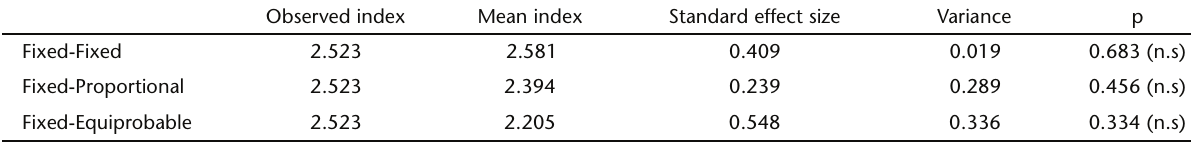
Table II. Results of null model analysis for co-occurrence of species at the studied sites (p values lower than 0.05 denotes random absence).